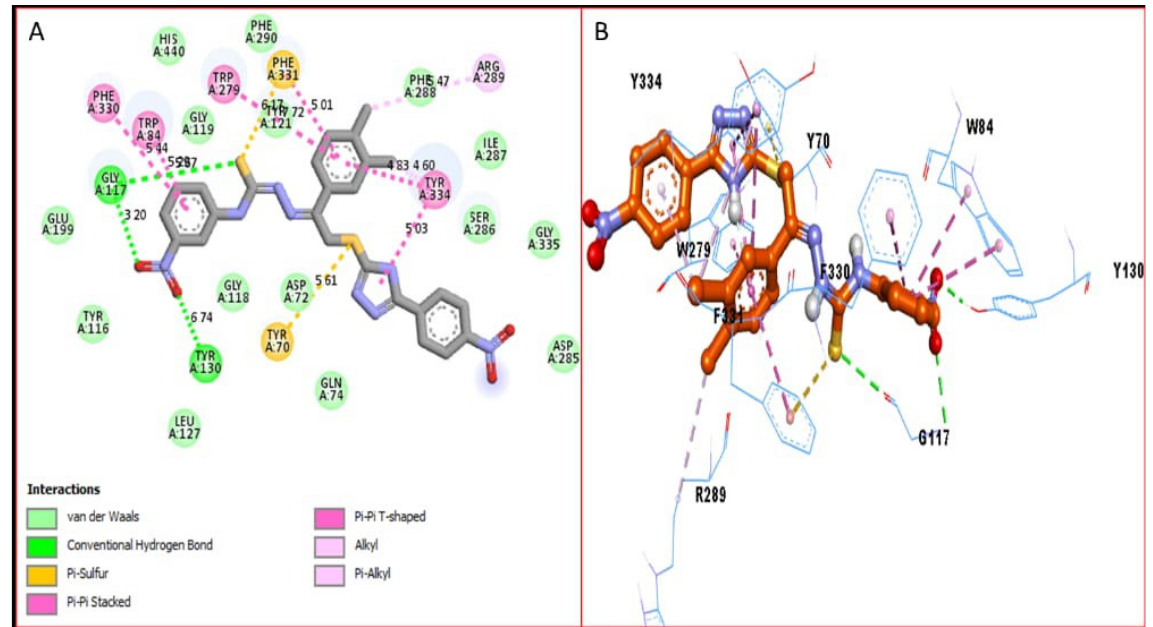
Figure 10. Protein–ligand interaction (PLI) profile of analogue 6q against butyrylcholinesterase (BuChE): ( A ) 2D; ( B ) 3D.